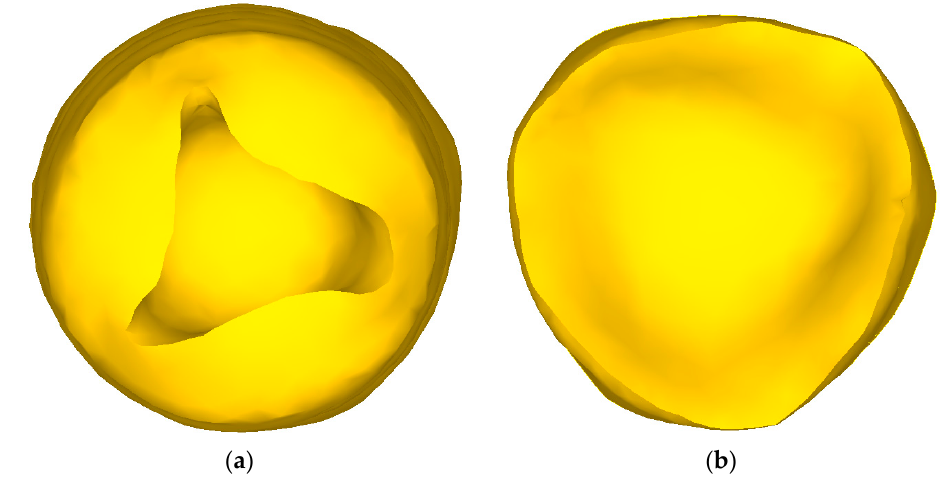
Figure 9. Shape of the billet ends in radial-shear rolling with a total compression of more than 20%: ( a )—front end; ( b )—back end.